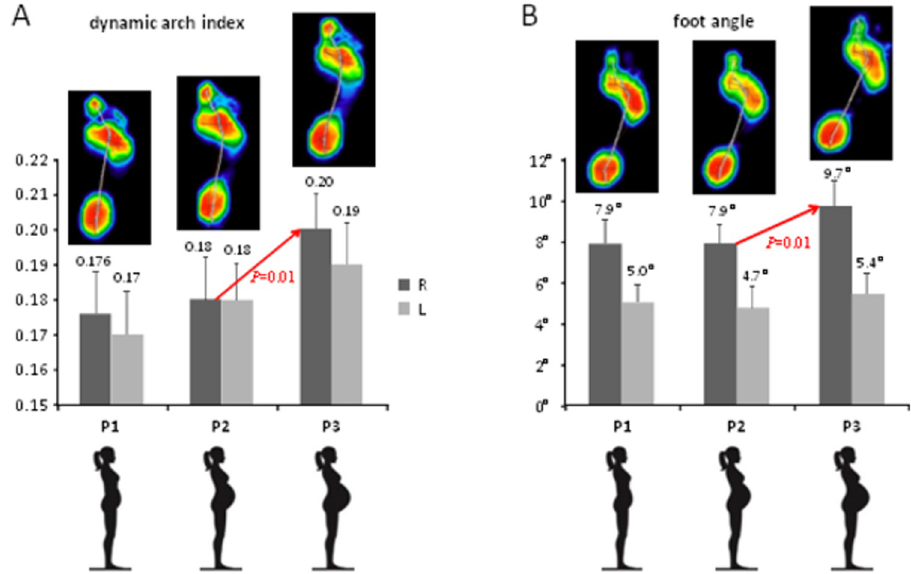
Fig 2. Foot loading characteristics in the 1 st (P1), 2 nd (P2) and 3 rd (P3) trimesters of gestation. A –dynamic arch index (mean ± SD). B –foot angle (mean ± SD). Upper colour footprints in A and B illustrate examples of averaged right foot pressure distribution patterns of individual subjects in the 1 st , 2 nd and 3 rd trimesters of